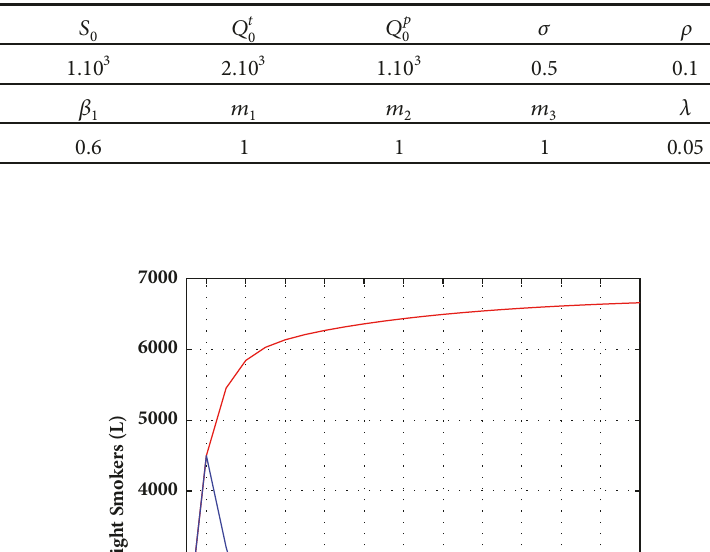
Table 2: The description of parameters used for the definition of discrete time systems (1). We used just arbitrary academic data.